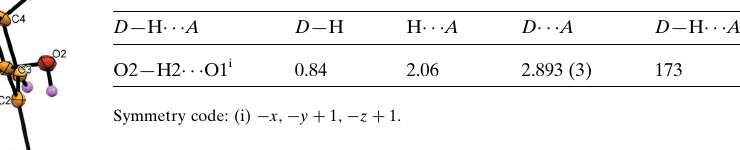
Table 1 Hydrogen-bond geometry (A˚ , (cid:4) ).